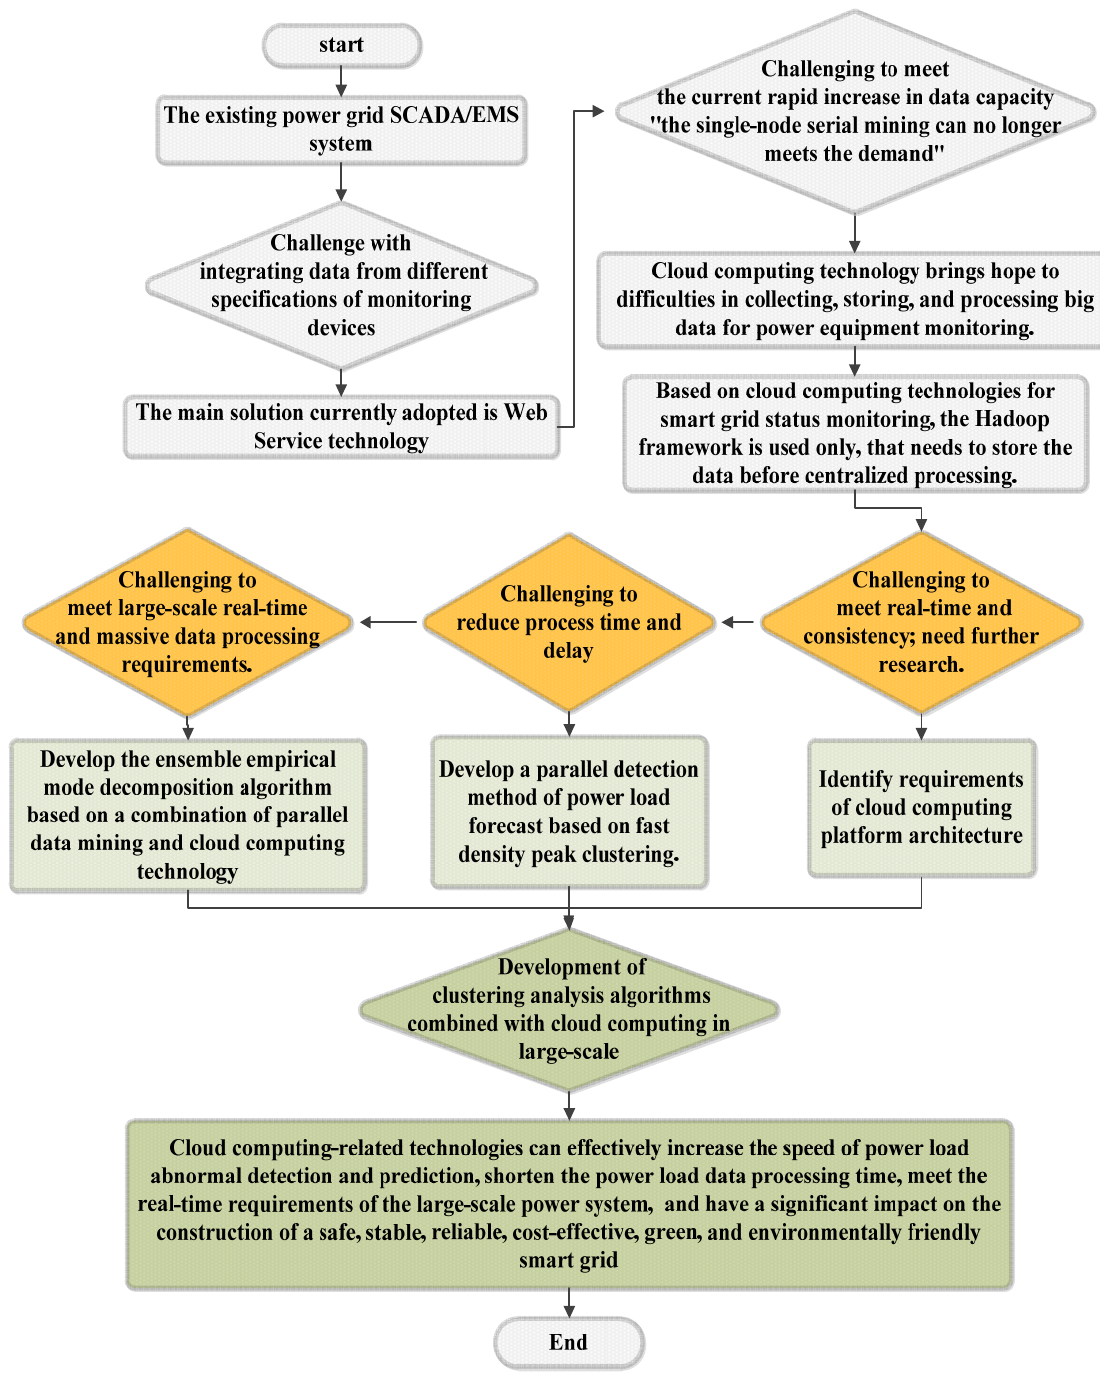
Figure 5. General flowchart for challenges and solutions the proposed system.